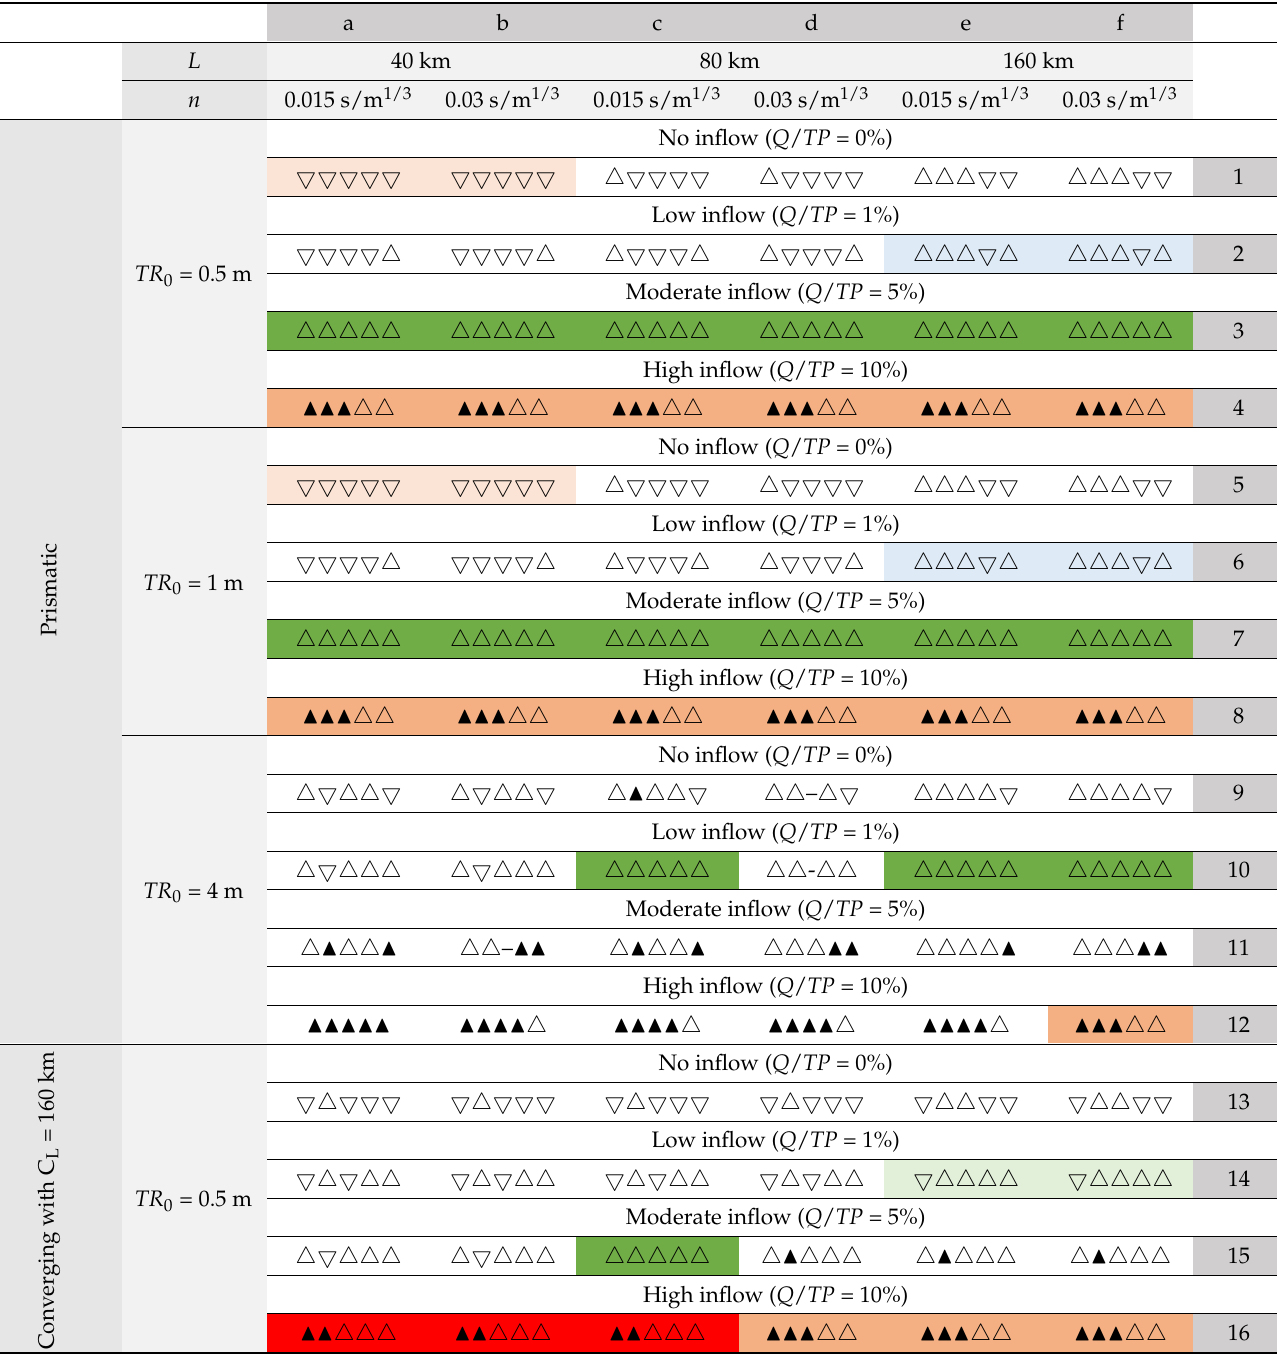
Table 2. Compounding effects of SLR and varying river inflows on maximum current velocity at five nodes along the estuaries ( x = 0, 0.25 L , 0.5 L , 0.75 L , and L ), which are represented by five consecutive triangles in each cell. Upward and downward triangles indicate an increase or a decrease in maximum current velocity induced by 1 m of SLR and for four varying river inflows ( Q / TP = 0%, 1%, 5%, and 10%). Hollow and solid triangles imply weak (0 ≤ | α | ≤ 0.5) and strong (0.5 < | α | ≤ 1) Pearson correlation coefficients, respectively. The symbol “–” denotes the absence of a correlation (for details, see [46]). Dominant patterns of change in tidal properties under compounding effects of SLR and river inflows are highlighted with similar colours across Tables